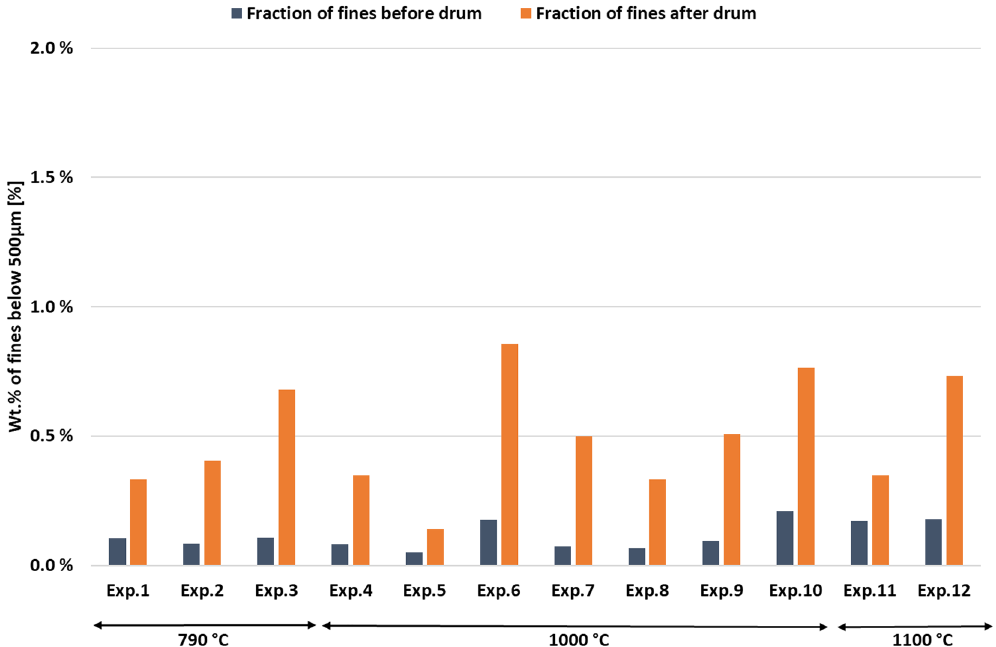
Figure 6. Fraction of fines (< 500 µm) before and after abrasion treatment in Hannover drum for alle experiments in experimental series